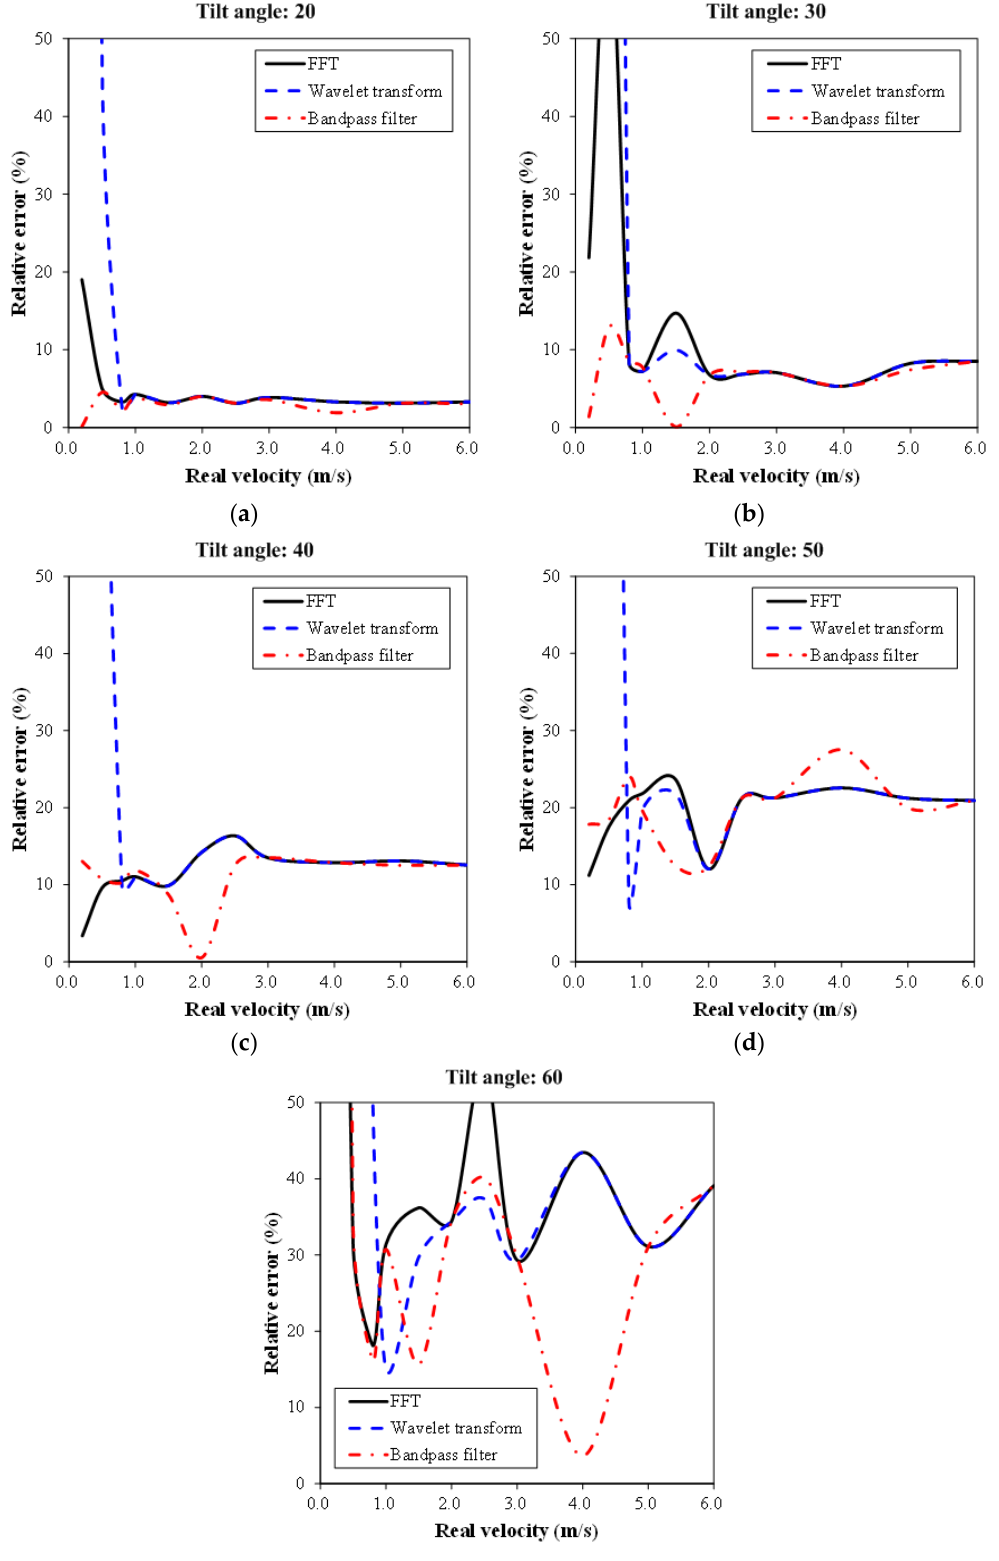
Figure 10. Comparison of the relative errors in flow velocity experimental analysis using the FFT, bandpass filter, and the wavelet transform. ( a ) Tilt angle = 20°; ( b ) Tilt angle = 30°; ( c ) Tilt angle = 40°; ( d ) Tilt angle = 50°; ( e ) Tilt angle = 60°.